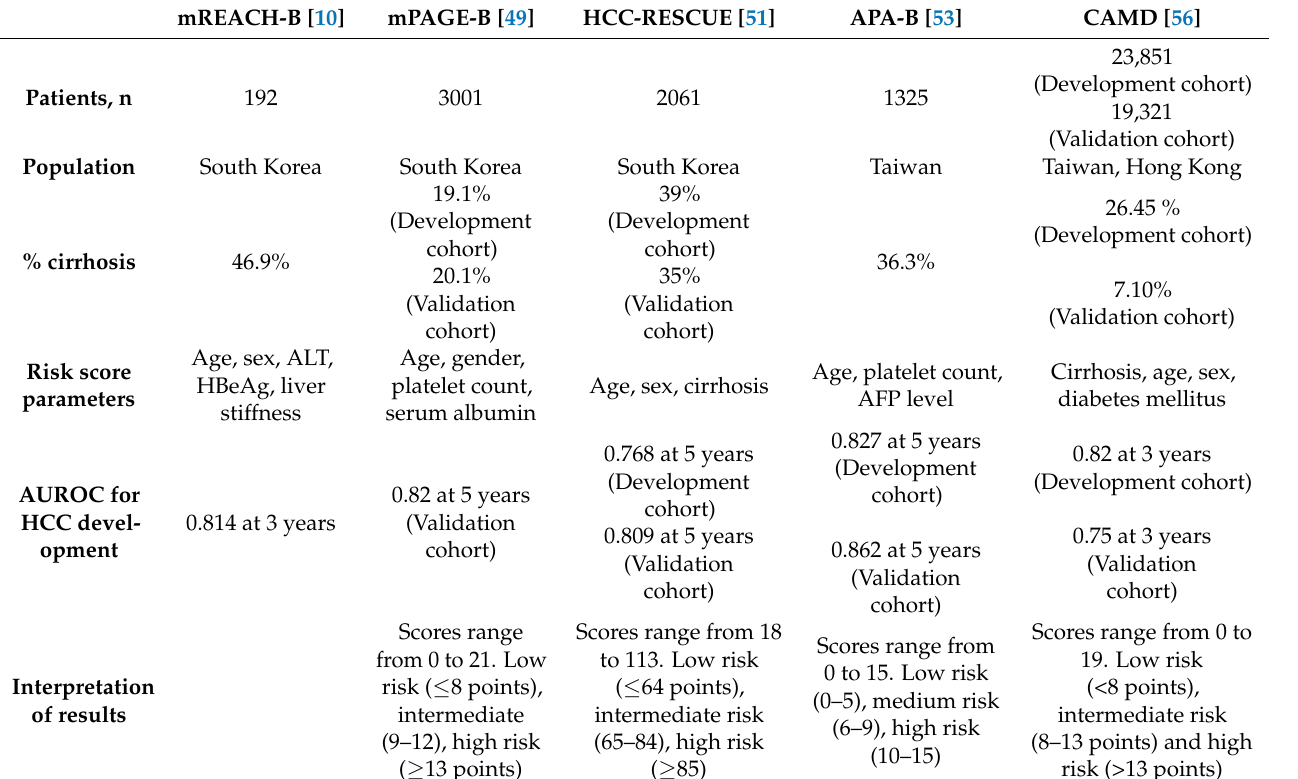
Table 2. Summary of recently developed HCC risk prediction